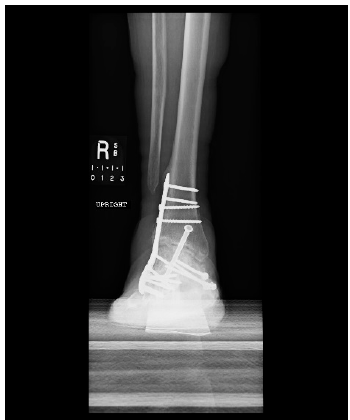
Figure A3. 2 years post-op imaging with screw fracture more displaced and an additional fracture in the proximal 3.5 mm cortical screw in the tibia.